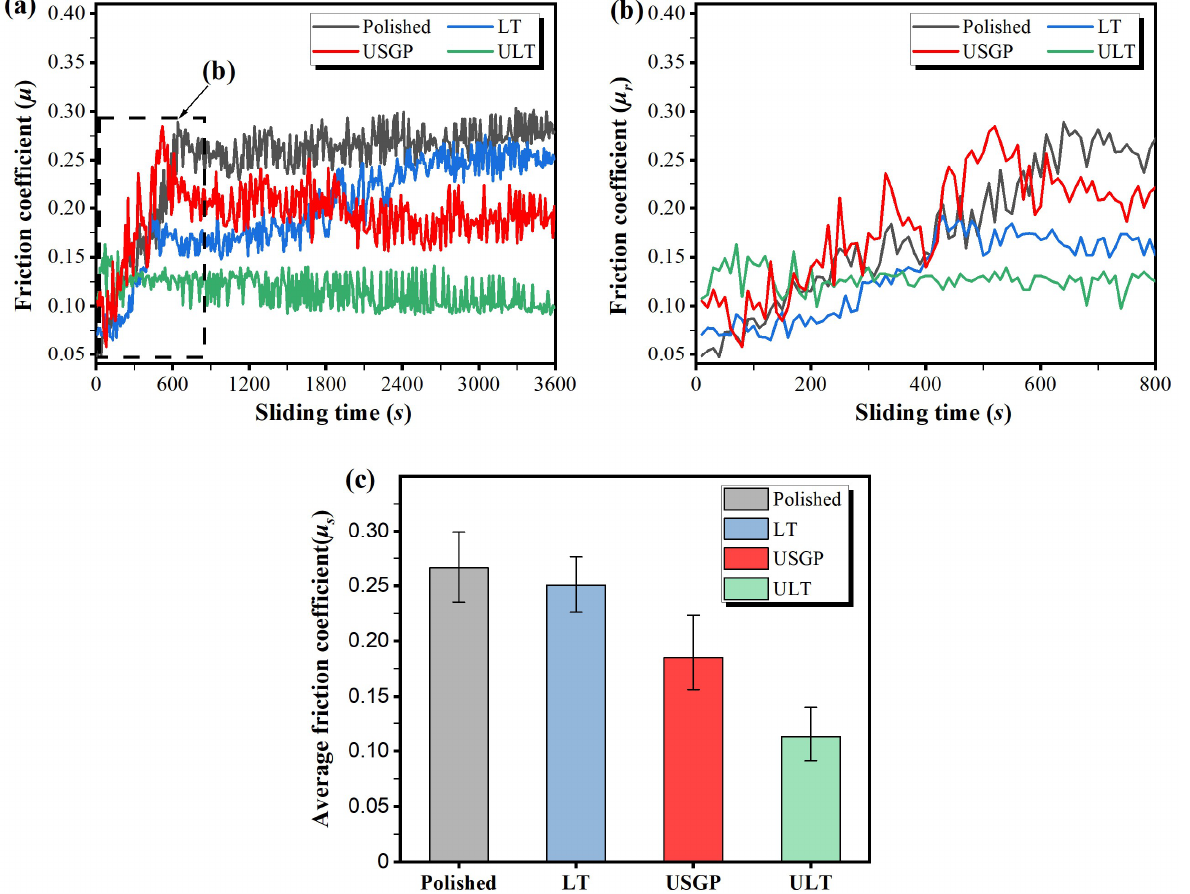
Figure 8. Variation in friction coefficient ( μ ) against the sliding time under a fixed normal load of 15 N at a constant sliding velocity of 30 mm/s for Ti6Al4V discs after different treatments ( a ); Variation in running-in state friction coefficient ( μ r ) against the sliding time ( b ) and the average friction coefficient ( μ s ) in steady-state of both samples ( c ).